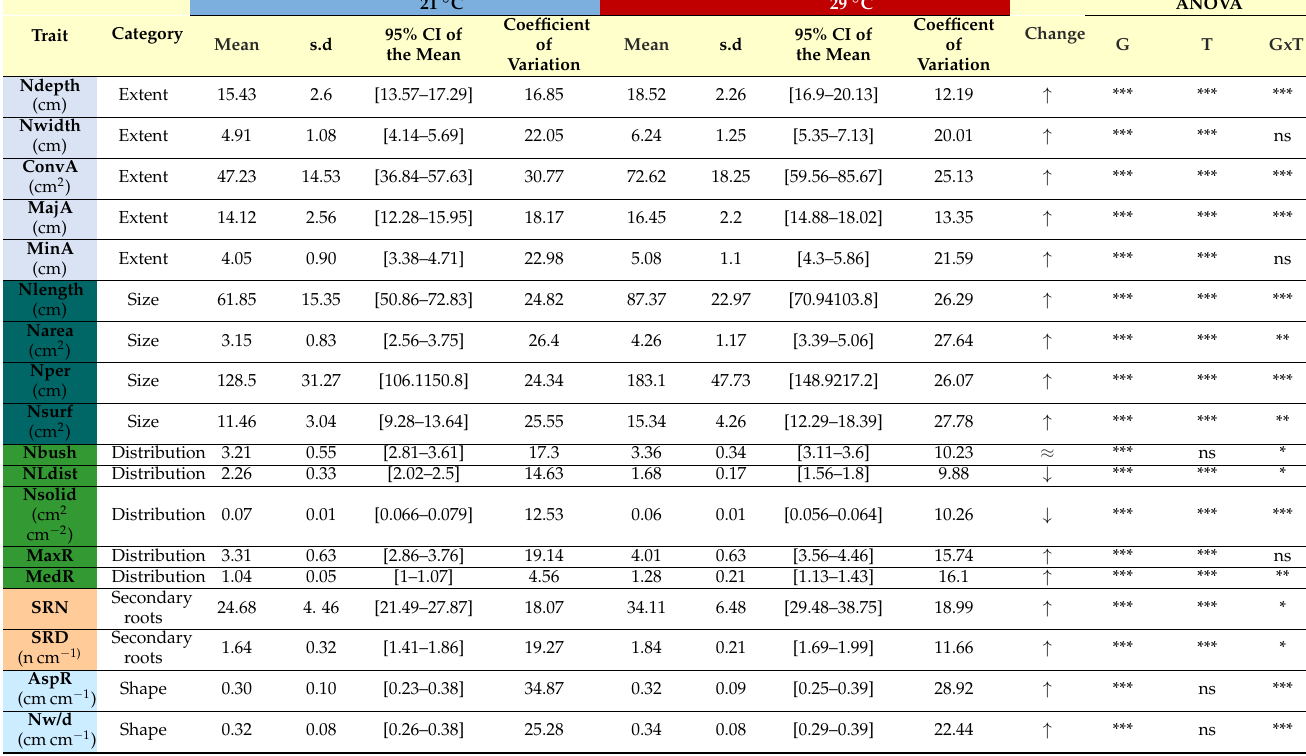
Table 1. Changes in major root traits of Brassica napus varieties result in extended and deeper root systems in response to warm temperatures. Comparative values of mean and coefficient of variation of major root traits classified according to their categories (extent, size, distribution, and shape-related traits) show significant changes in most traits between 21 ◦ C and 29 ◦ C in all Brassica napus varieties analyzed. Two-way ANOVA analysis of contribution of genotype (G), temperature (T), and genotype x temperature interaction (GxT) to changes in root trait values after warm temperature treatment were also assessed. Significant differences are indicated by asterisks, * p < 0.01, ** p < 0.001, *** p < 0.0001, and ns shows non-significant differences. Ndepth (network depth, cm), Nwidth (network